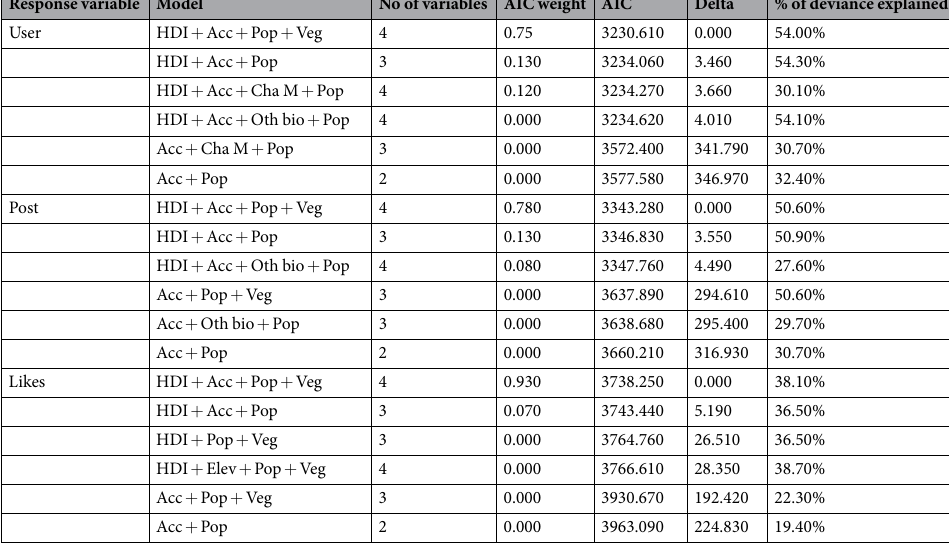
Table 1. Top-ranked predictors of social media usage within Sub-Saharan Africa protected areas. Akaike Information Criteria (AIC) weights represent the probability of the model being the best